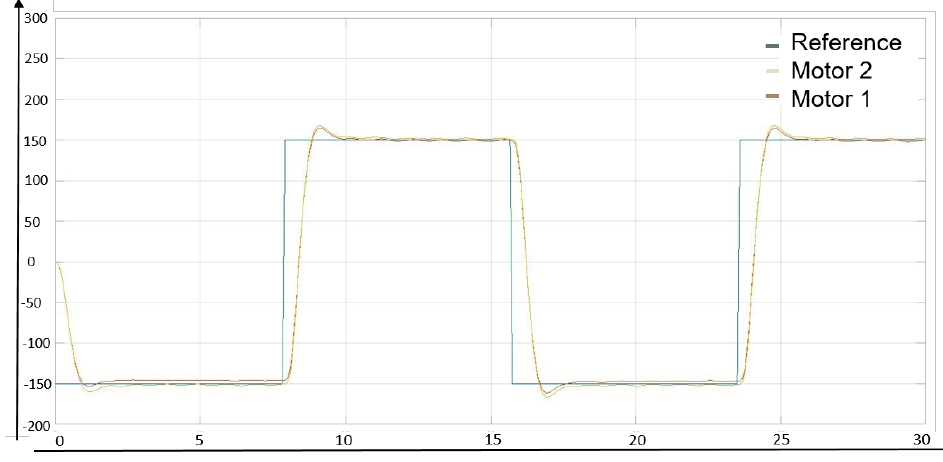
Figure 6. Behavior using PI with optimization values, test 19.